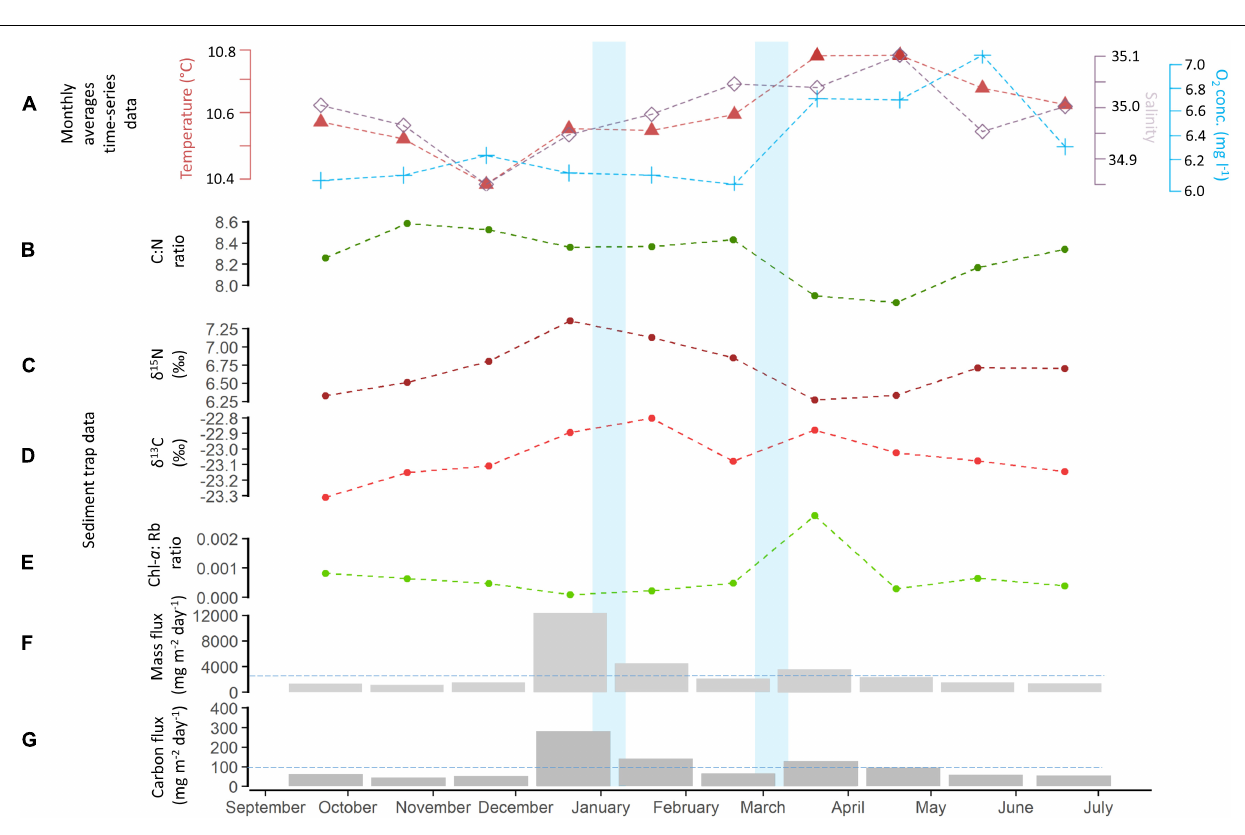
Frontiers in Marine Science |